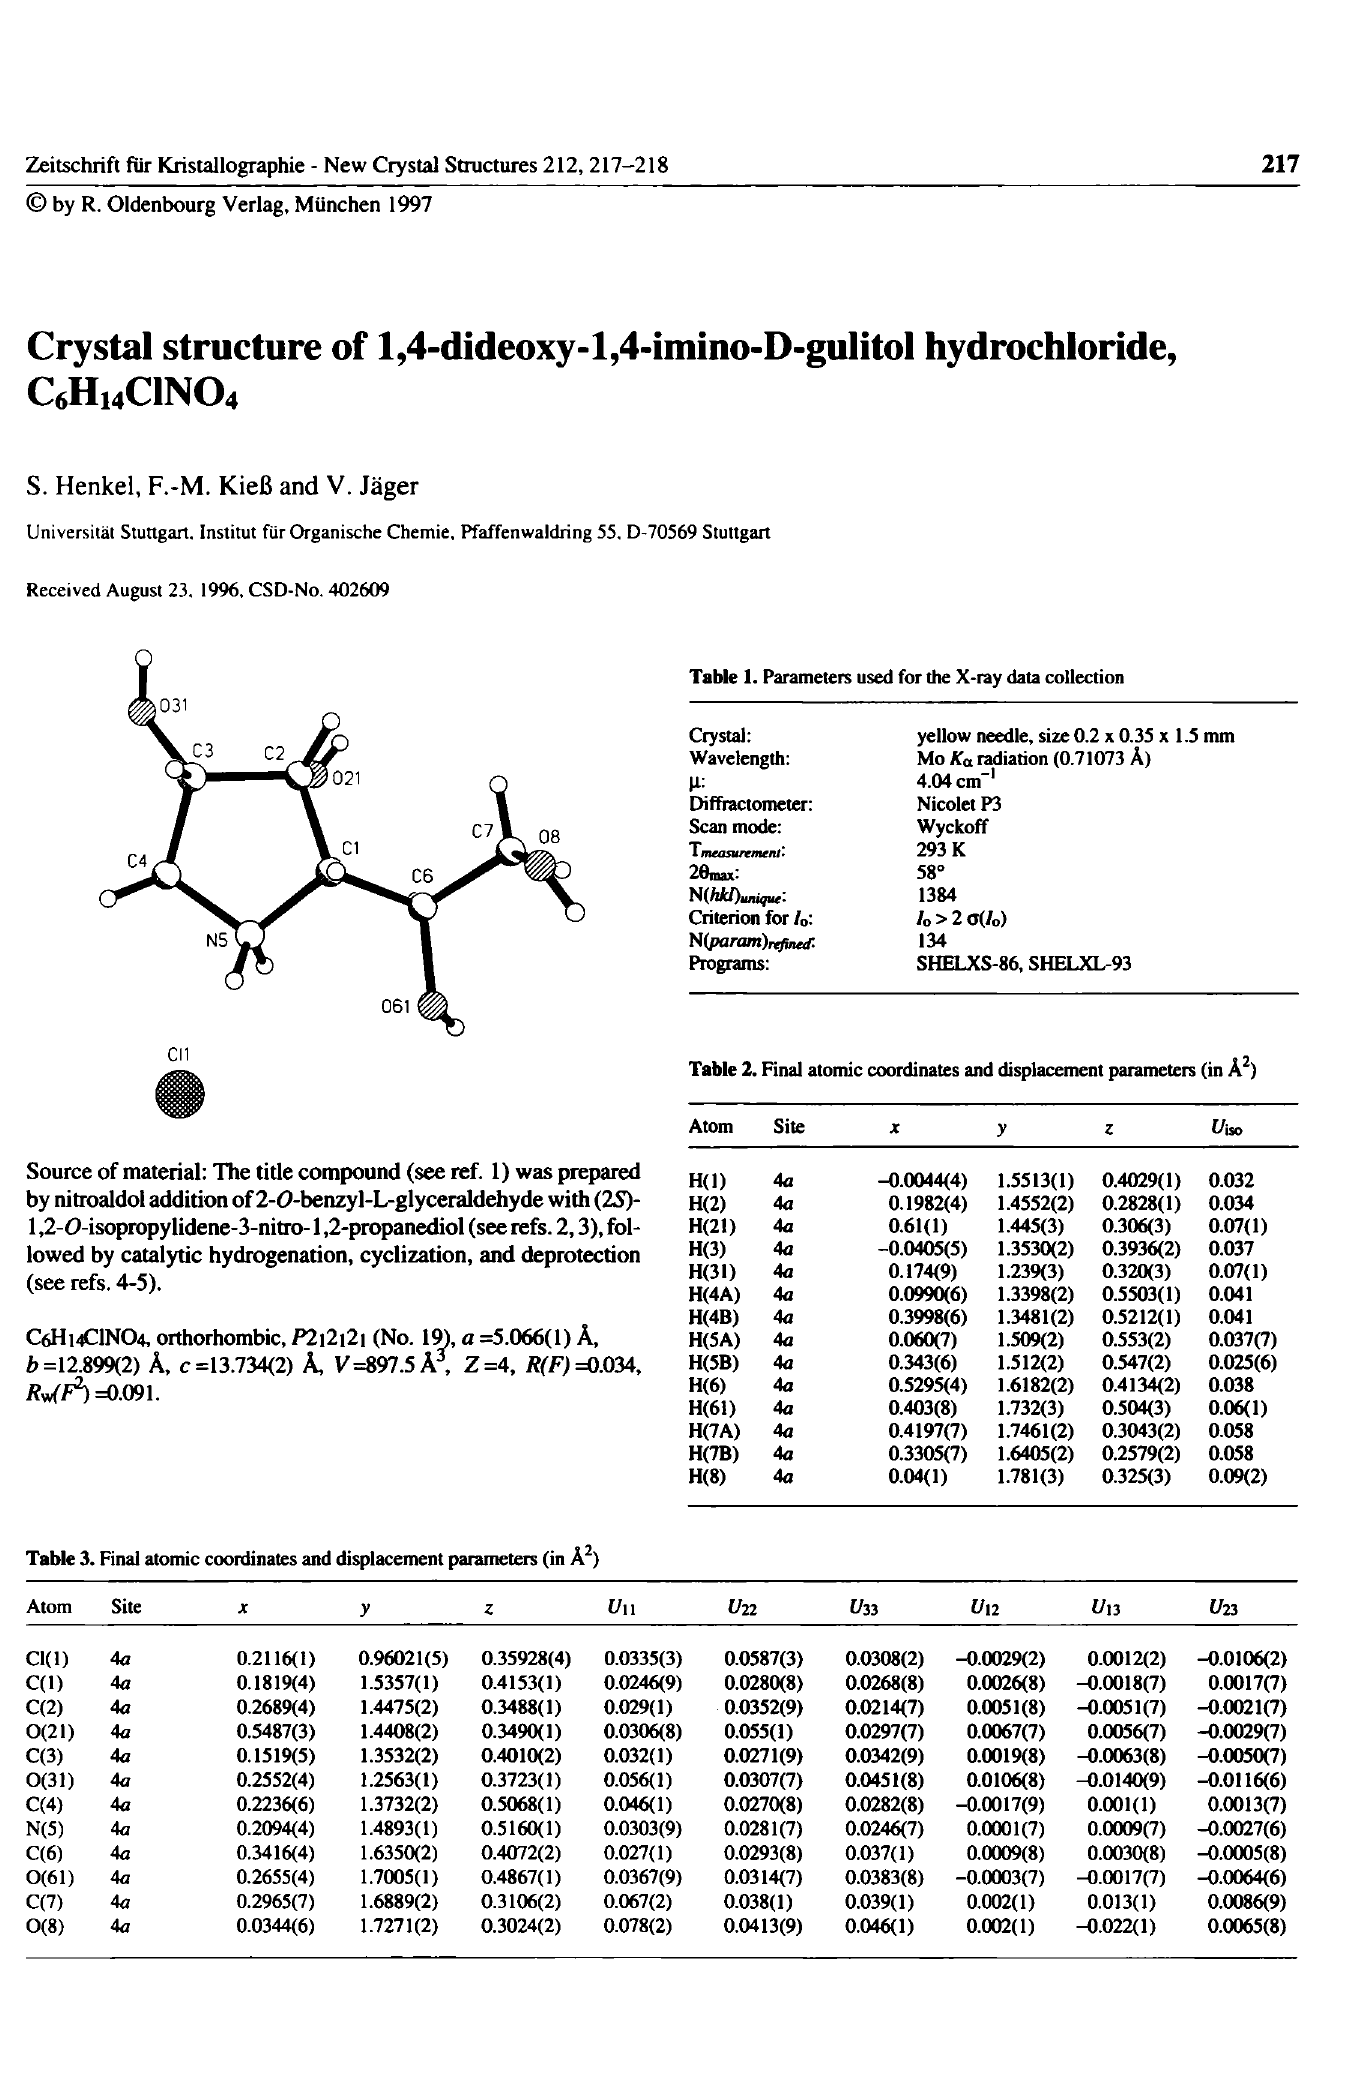
Table 3. Final atomic coordinates and displacement parameters (in Â 2 ) Atom